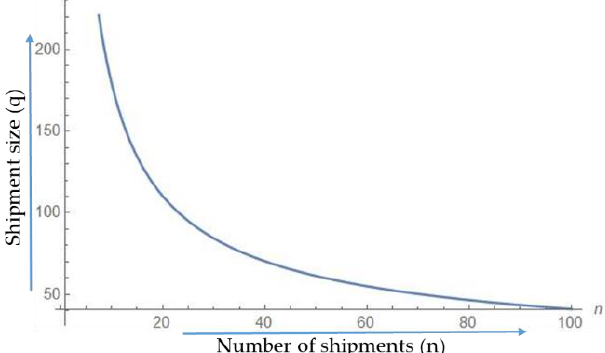
Figure 7. Impact of number of shipments on optimal shipment size.